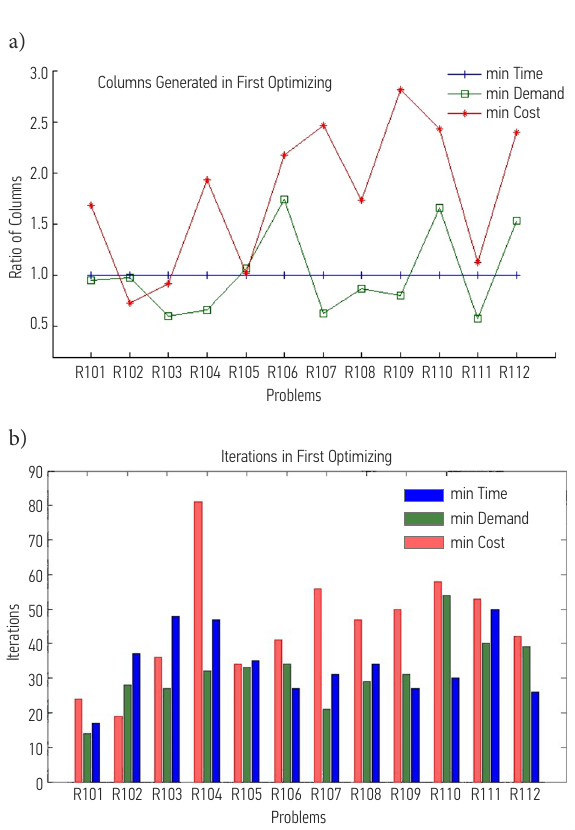
Fig. 1. Total number of searching path and iteration number in the condition of different path selecting